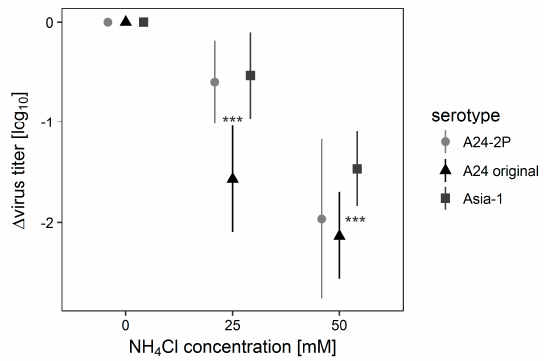
Figure 3. Different NH 4 Cl sensitivity of FMDV serotypes A and Asia-1. BHK monolayers as well as suspension cells were treated with 50 mM or 25 mM ammonium chloride or left untreated. BHK179 were infected with FMDV Asia-1 Shamir and A 24 Cruzeiro (original), and BHK-2P were infected with the adapted virus strain A24-2P. After 24 h of incubation, the remaining infectivity was determined by titration. Values on the y-axis represent the reduction in virus yield compared to untreated cells. Experiments were performed in duplicates three times independently. Significance code: *** p <